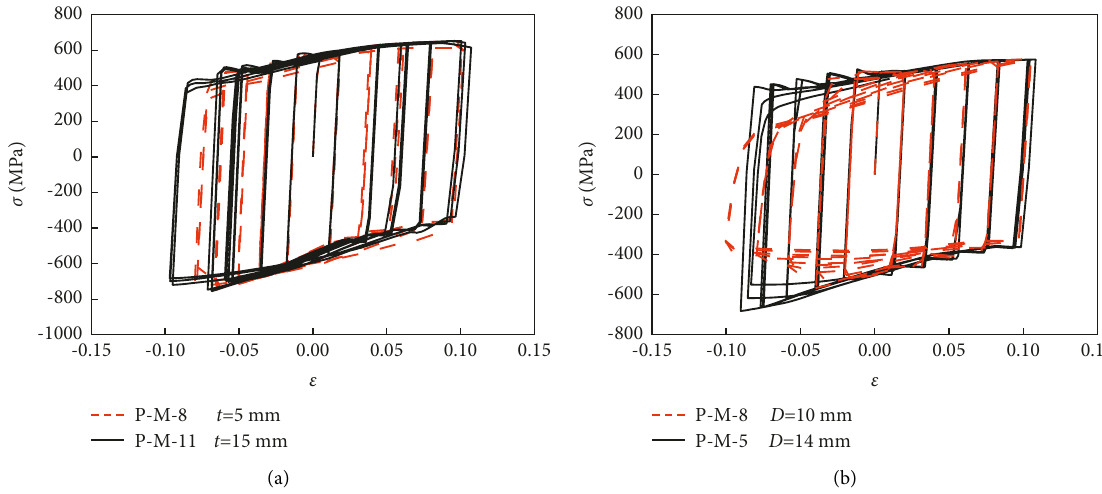
Figure 17: Hysteresis curves of material specimens with different thickness or diameter. (a) Hysteresis curves of specimens in group P-M. (b) Hysteresis curves of specimens in group R-M.